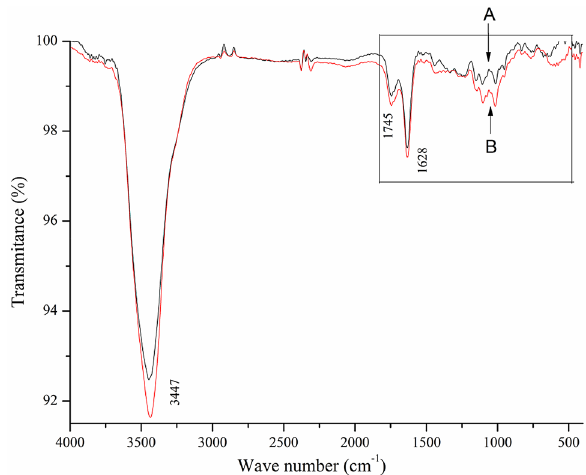
Figure 4. FT-IR spectra of FP ( A ) and SP ( B ).